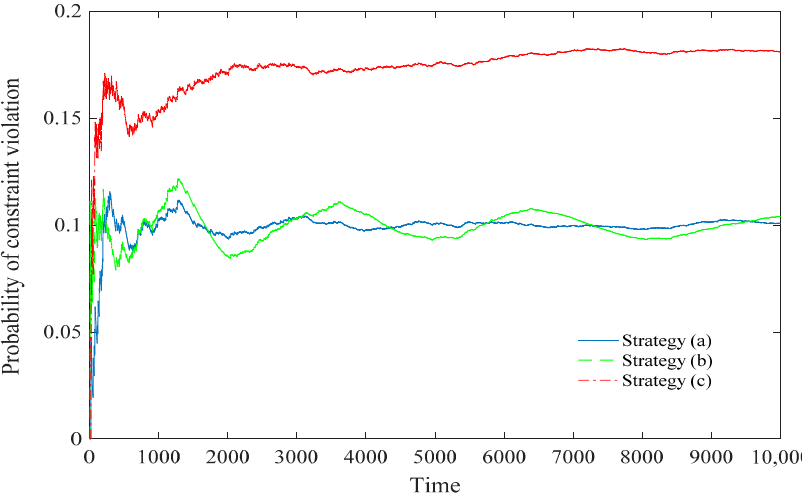
Figure 7. Comparison on constraint violation probabilities among different adaptive constraint update strategies. Table 4. Comparison on transient characteristics between Strategy (a) and Strategy